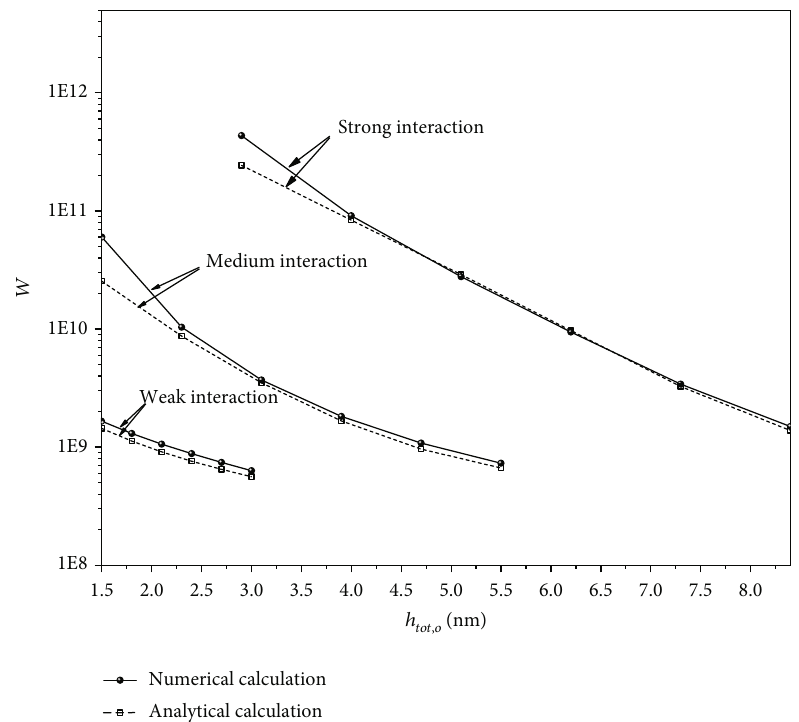
Figure 9: Comparisons of the analytically calculated dimensionless load of the present model of the bearing with those numerically calculated for di ff erent fl uid-bearing surface